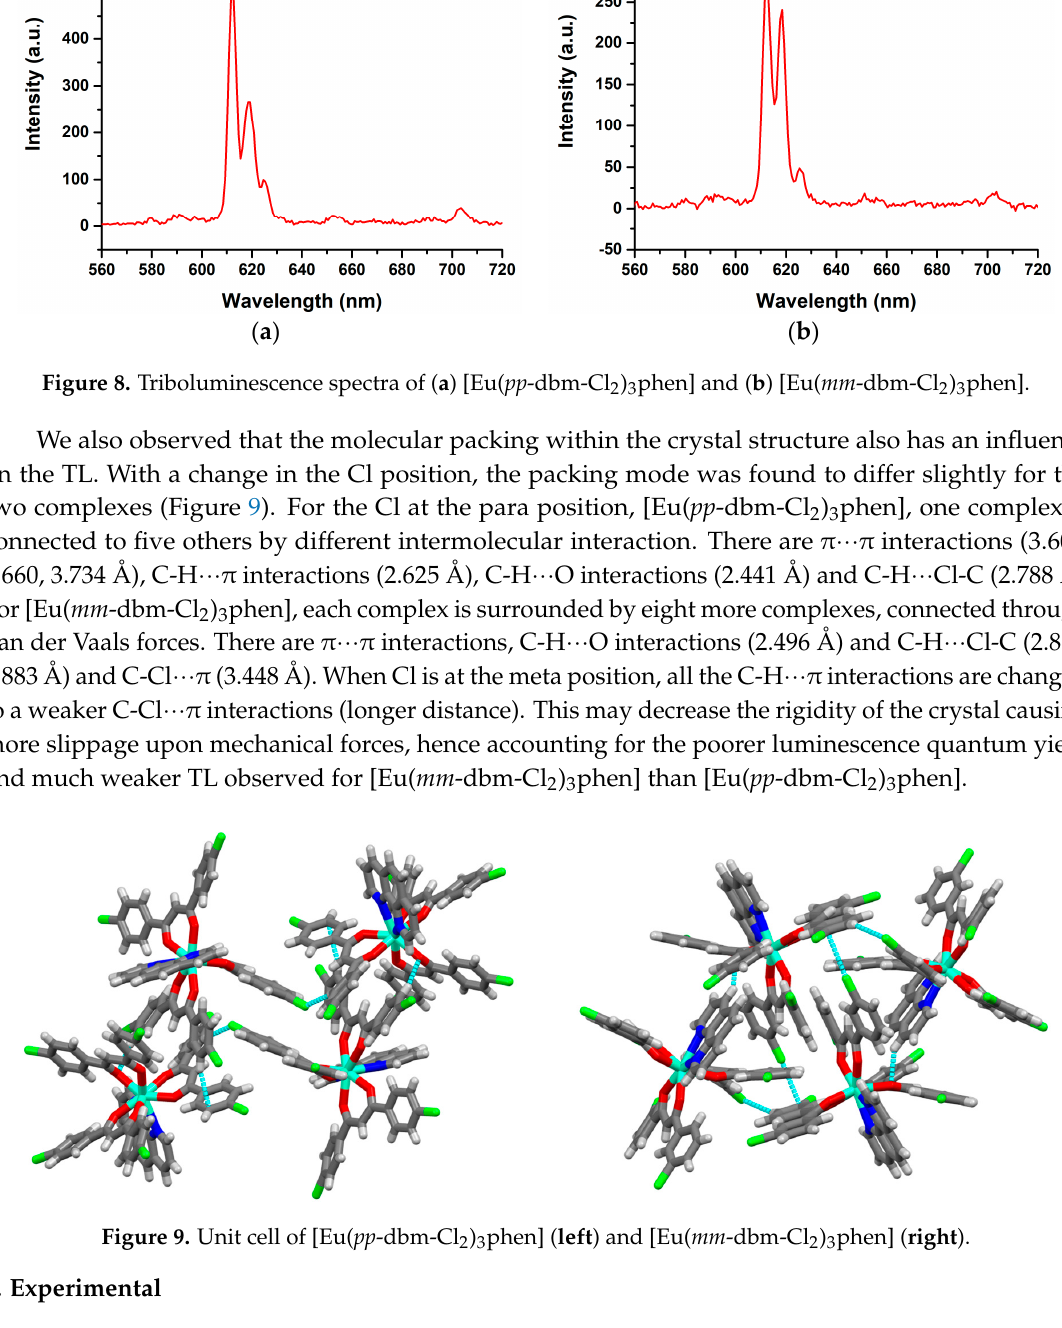
2 ) 3 phen] and ( b ) [Eu( mm -dbm-Cl 2 ) 3 phen].